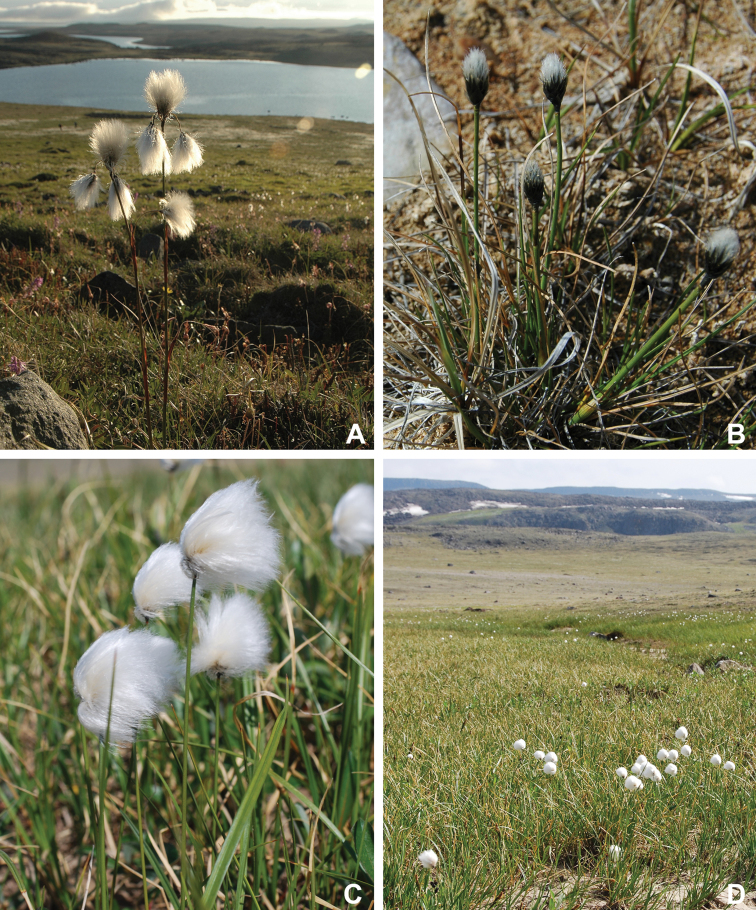
AEriophorum
angustifolium habit, Gillespie et al. 9984BEriophorum
callitrix habit, Gillespie et al. 7477CEriophorum
scheuchzeri
subsp.
arcticum inflorescences DEriophorum
scheuchzeri
subsp.
arcticum habitat, Gillespie et al 9857 & 9861. Photos A, B by R.D. Bull and C, D by J.M. Saarela.